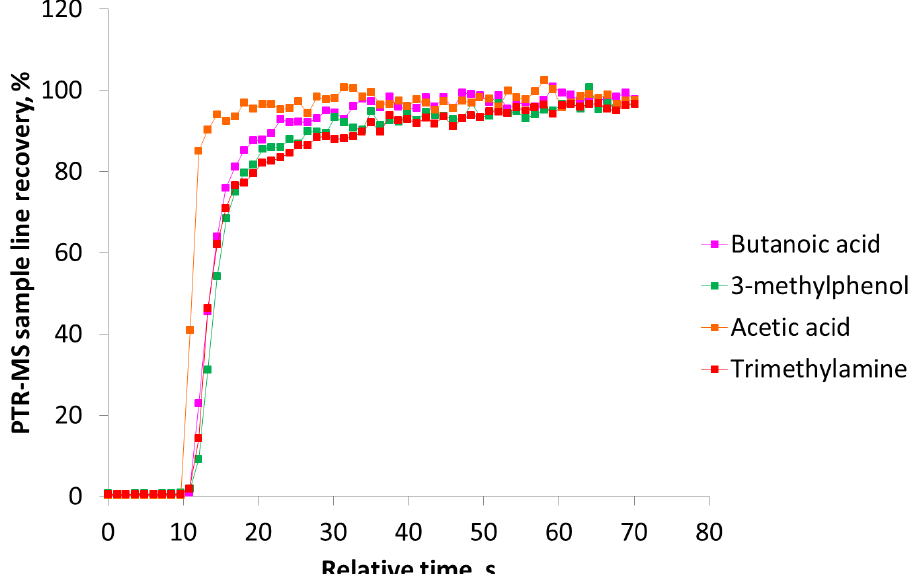
Figure 4. PTR-MS response time for individual odorants measured with a 1.2 m PEEK sampling line heated to 60 °C. The PTR-MS response time was defined as the time to reach 90% of the final concentration when changing from a highly diluted sample to an undiluted sample (relative time = 10